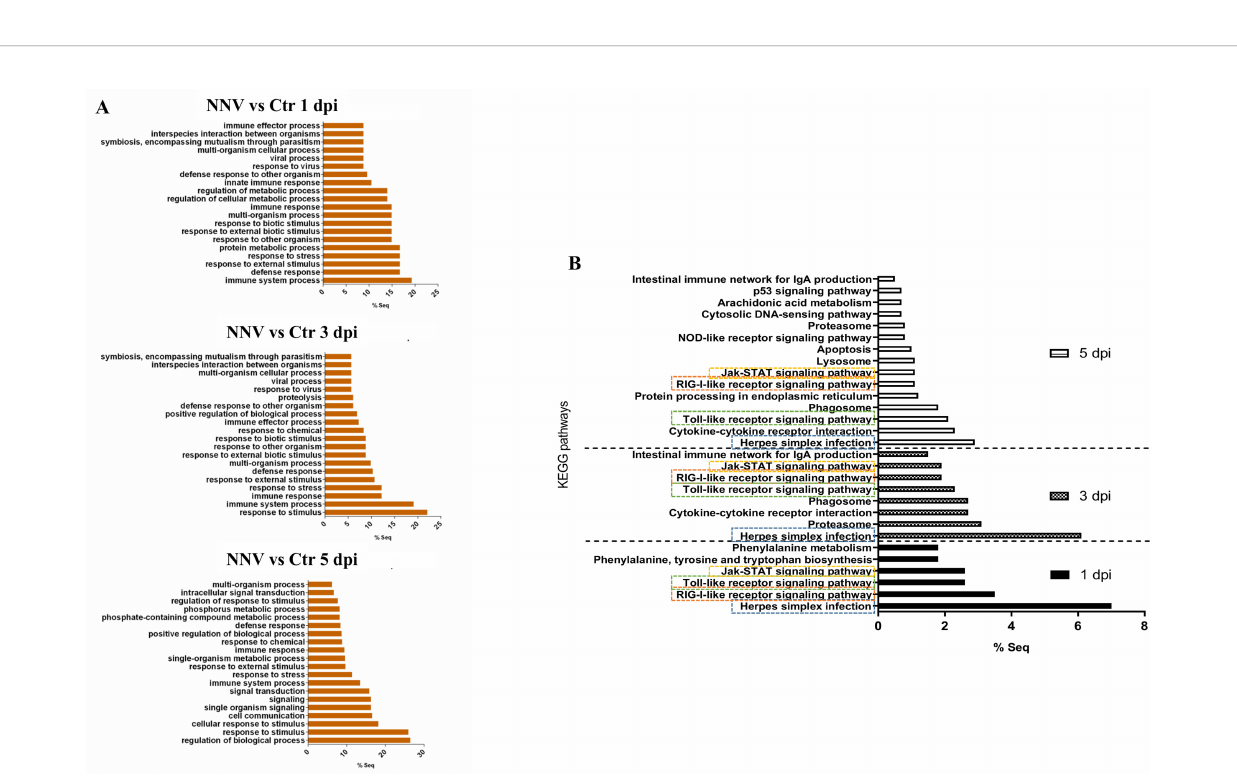
FIGURE 7 | GO terms and KEGG pathways enriched during NNV infection of zebra fi sh larvae. (A) GO biological process terms signi fi cantly enriched at 1, 3, and 5 dpi. (B) KEGG pathways enriched at 1, 3, and 5 dpi; the four common pathways signi fi cantly enriched over time are